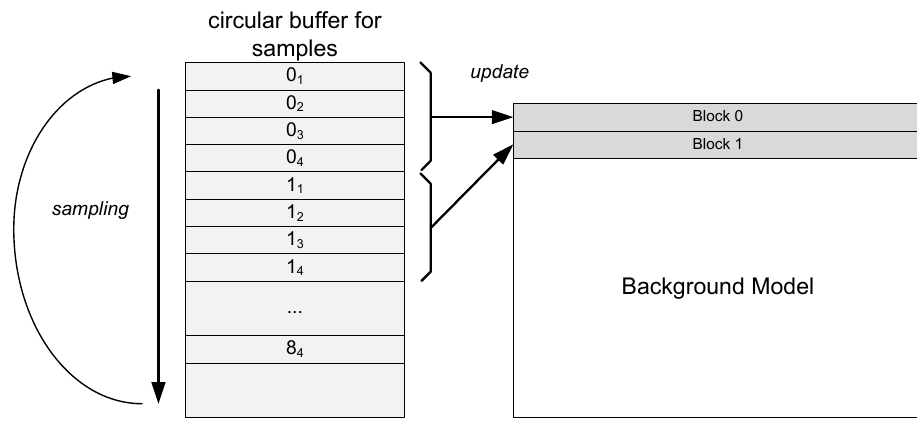
Figure 7. Background model update spatial